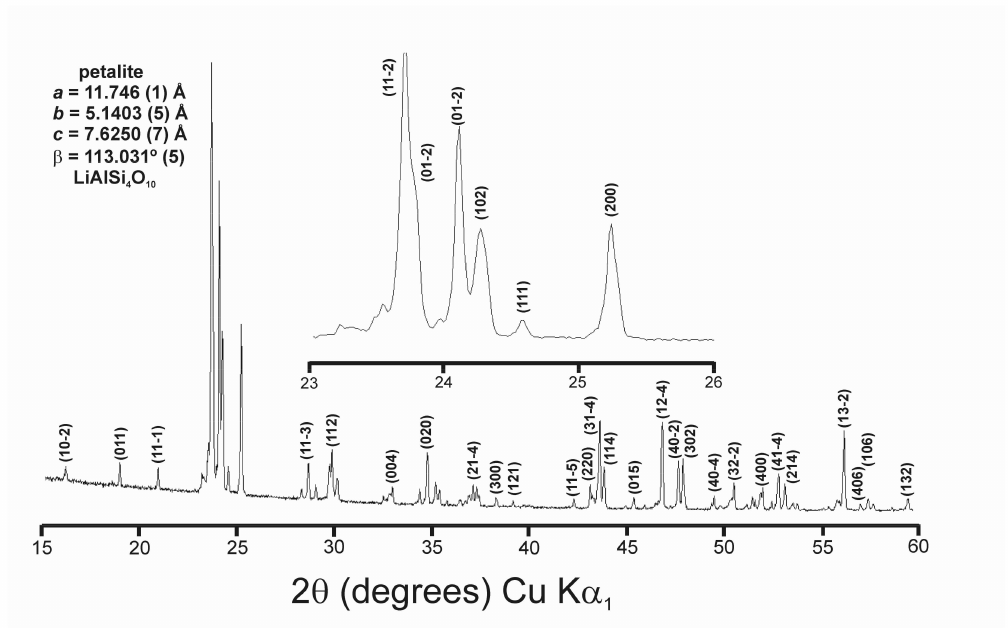
Figure A2. Powder XRD pattern of petalite LiAlSi 4 O 8 with Rietveld refinement cell parameters as a = 11.746 (1) Å, b = 5.1403 (5) Å and c = 7.6250 (7) Å, α = 90 ◦ , β = 113.031 ◦ (5), and γ = 120 ◦ in a model P 2/a in specimen Brazil , very similar to file CC 100348 in ICSD database, with a = 11.7540 (11) Å, b = 5.1395 (5) Å, c = 7.6296 (7) Å, α = 90 ◦ , β = 113.04 ◦ (1), and γ = 90 ◦ , from Effemberger (1980)